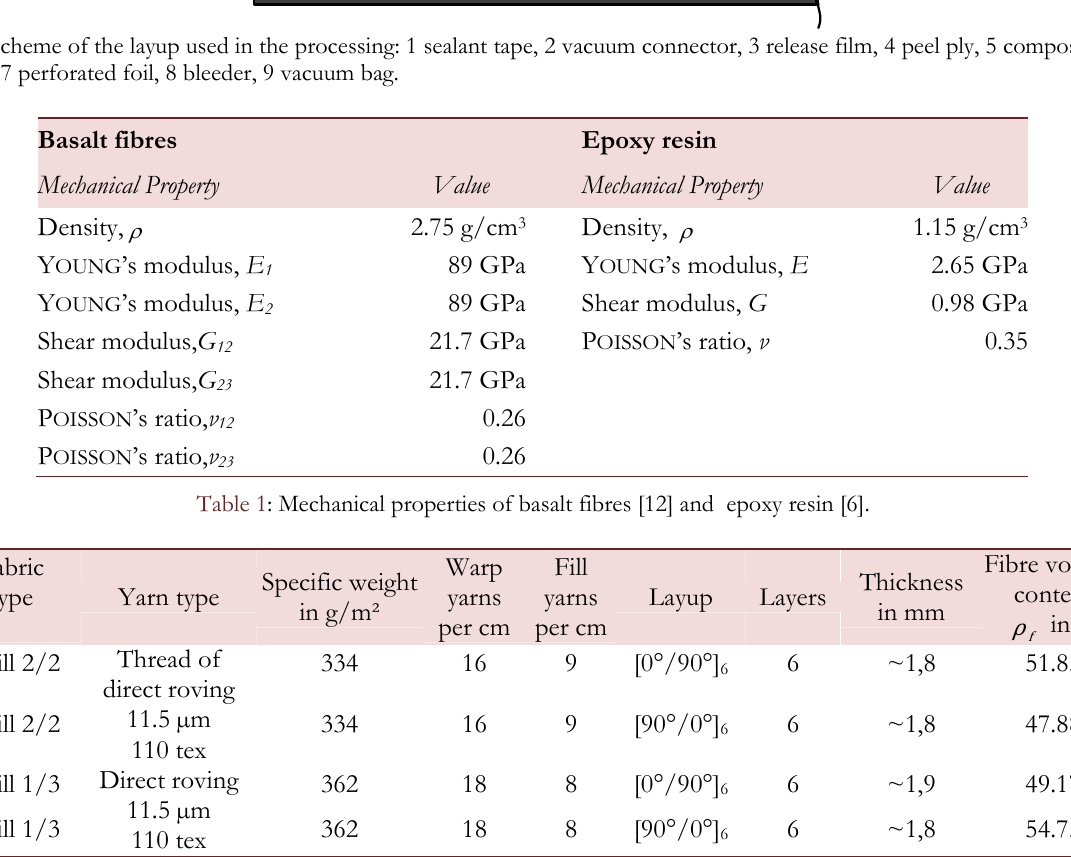
Table 2: Types of fabrics, specific weights and